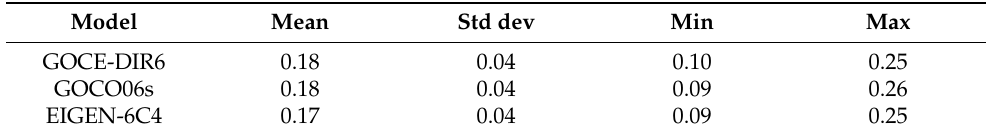
Table 5. Assessment of the accuracy of the subsequent quasigeoid models at the points of ASG- EUPOS network and EVRF2007 vertical system. Model Mean Std dev Min Max GOCE-DIR6 0.18